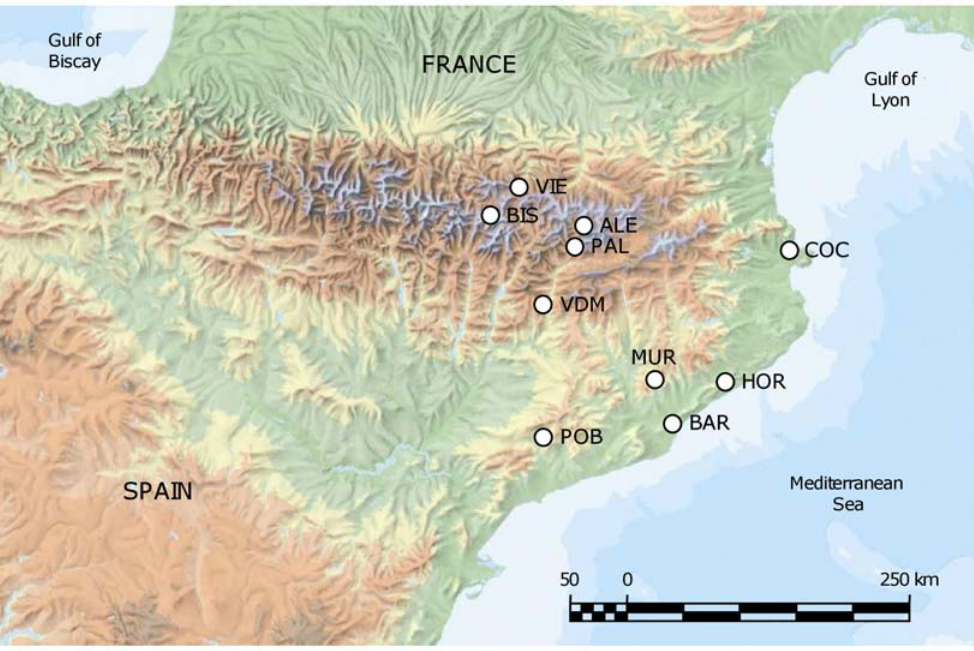
Figure 1. Geographic location of populations. The map shows the location of A. thaliana populations of study in coastal (BAR, COC, HOR, MUR, and POB) and montane (ALE, BIS, PAL, VDM, and VIE) areas in NE Spain.